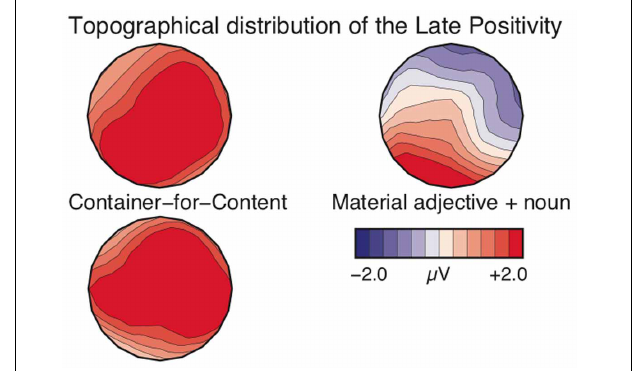
FIGURE 4 | Topographical distribution of the positivities from container-for-content alternations (left panel) and material adjective + noun combinations (right panel). The top row depicts the 550–750ms window and the bottom row corresponds to the 900–1100ms window. Frontal electrodes are at top of